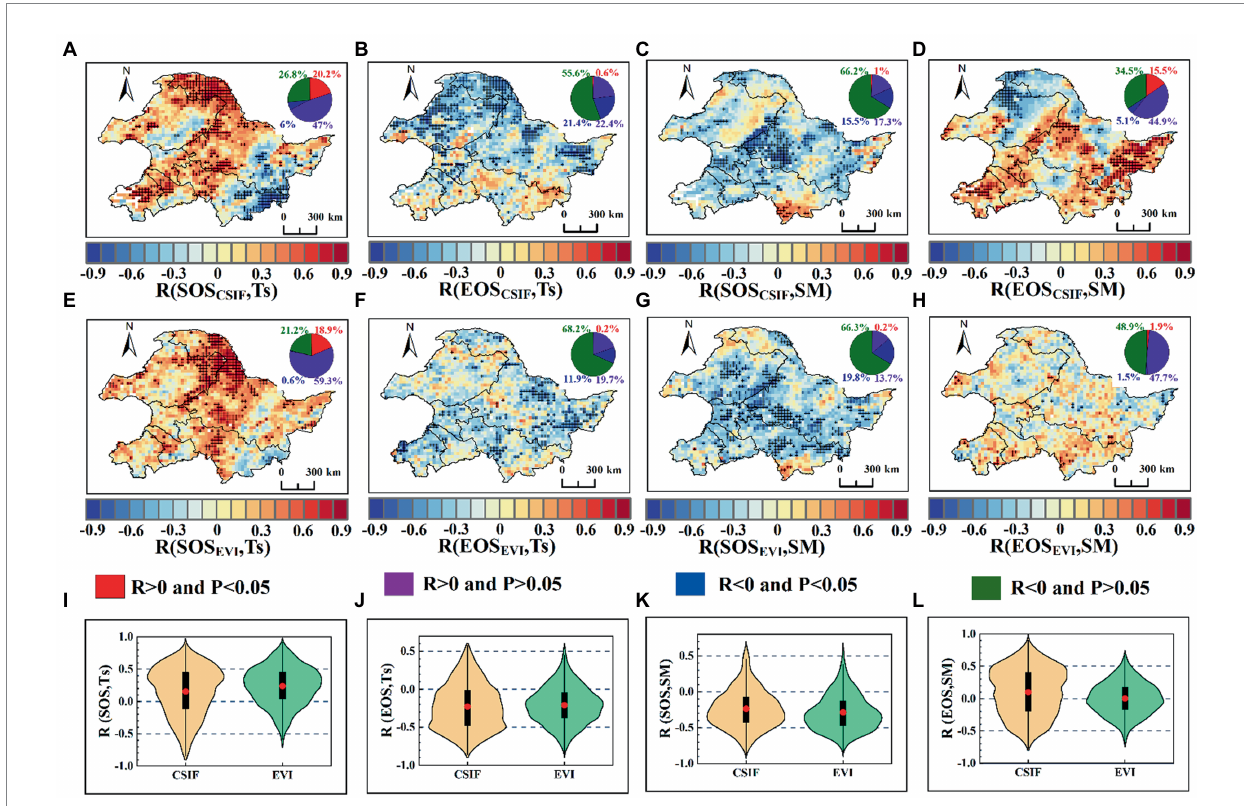
FIGURE 4 Spatial patterns of correlations between SOS and EOS extracted from CSIF and EVI and pre-season Ts, SM. (A–D) Spatial patterns of correlation coefficients between SOS, EOS derived CSIF and preseason Ts, SM; (E–H) Spatial patterns of correlation coefficients between SOS, EOS derived EVI and preseason Ts, SM; (I–L) Violin plots, where red dots indicate the mean, black rectangular boxes cover the interquartile range, and thin black lines reach the 5th and 95th percentiles. The black dot markers indicate that the 95% significance level was